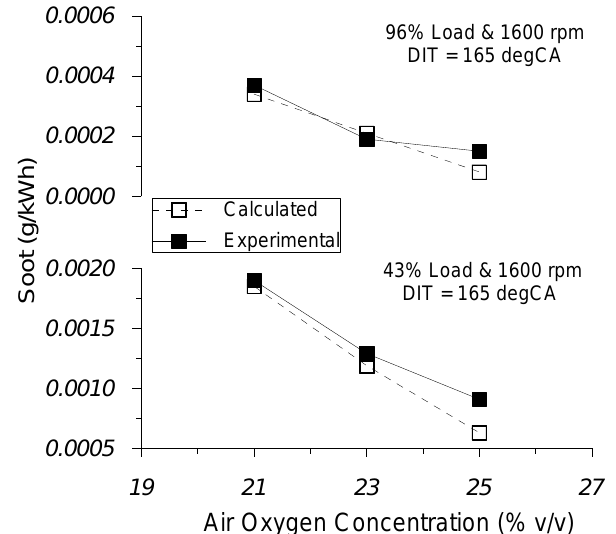
Figure 6. Comparison between experimental and computed specific Soot concentration as a function of “inlet-air oxygen ratio”, for N = 1600 rpm and “a” = 20%, at 43% and 96% of engine rated load.